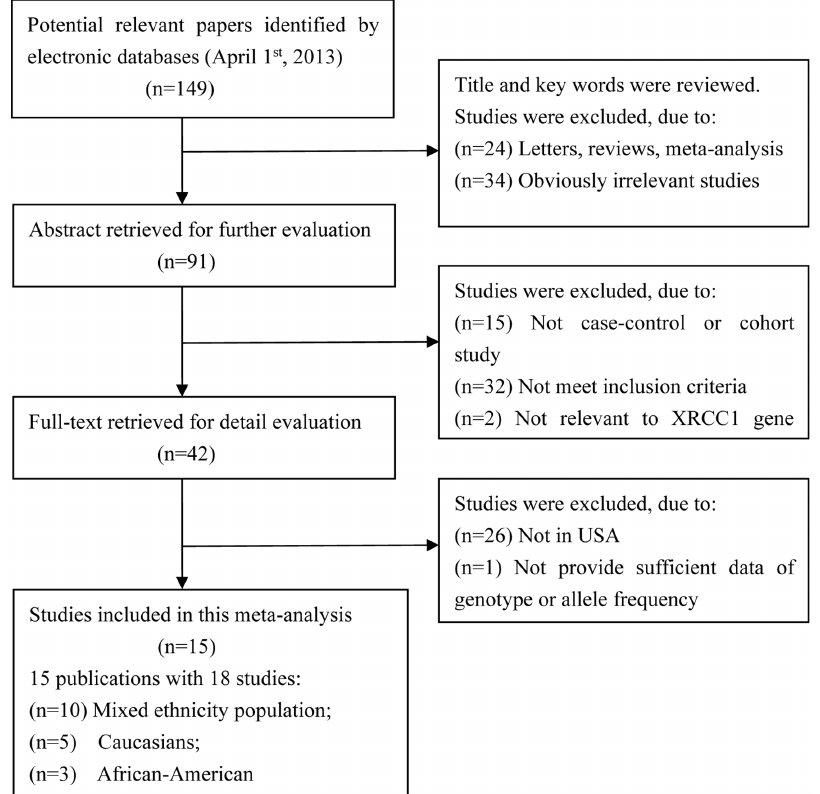
Figure 1. Flow chart of literature search and selection in the meta-analysis.